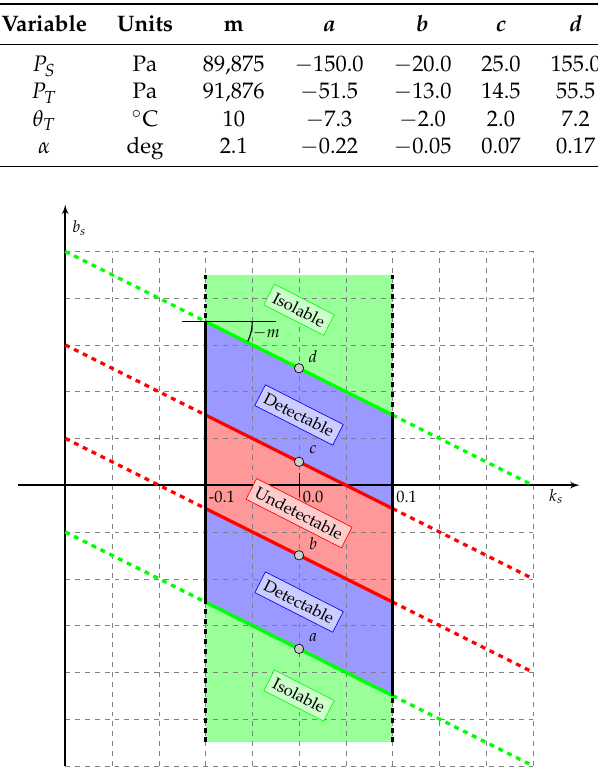
Figure 6. Representation of the fault parameter